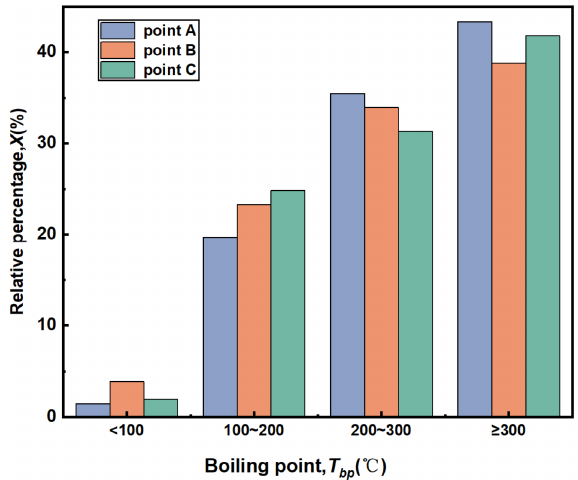
Figure 8. The boiling point range of compounds in tar.